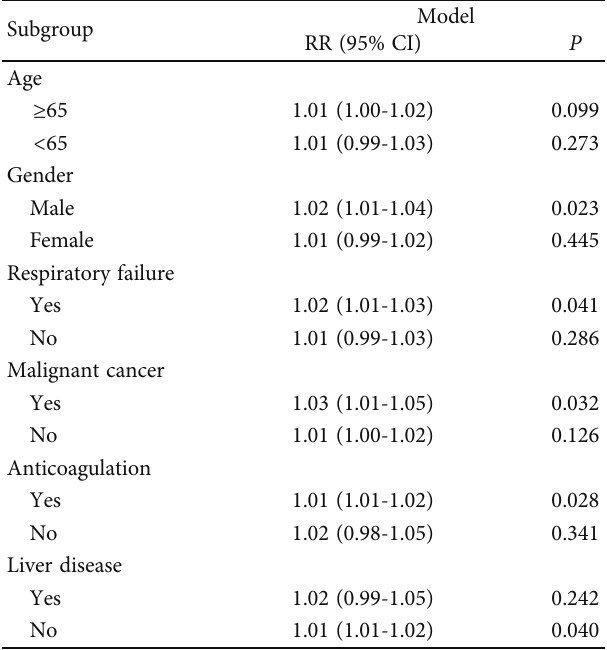
Table 3: The association between BUN/Cr and mortality of patients with cerebral infarction in di ff erent subgroups.